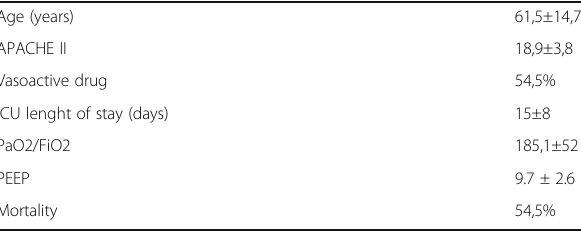
Table 1 (abstract 000952). Clinical Characteristics